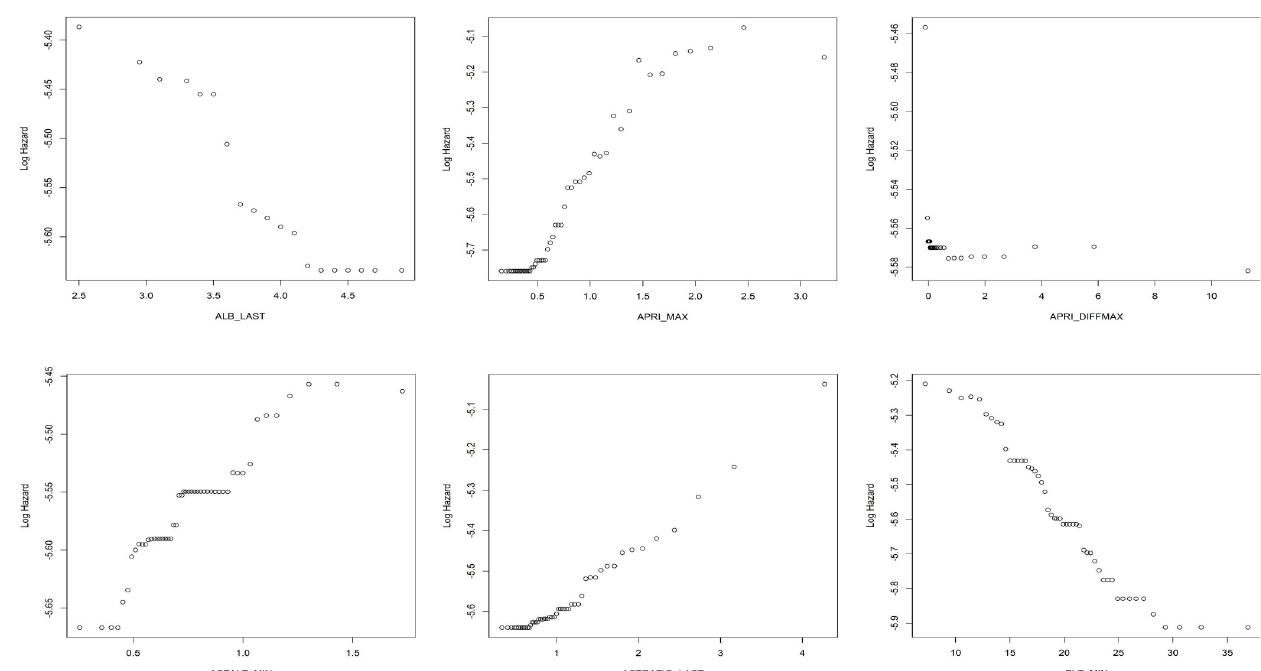
Fig 6. Partial dependence plots for the longitudinal boosting model.